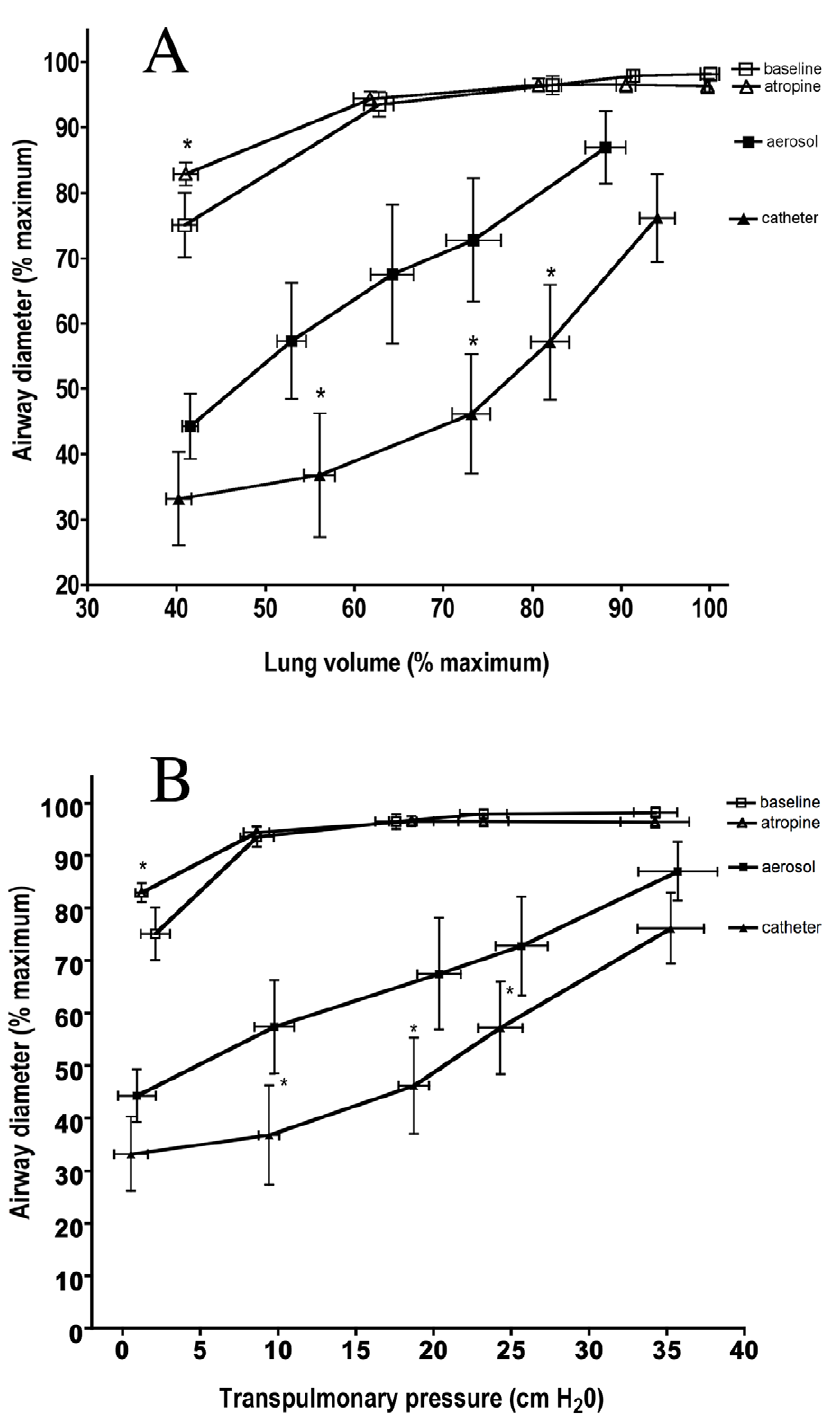
Figure 1. A: The mean ( 6 SEM) airway diameter (as a percentage of the maximum airway diameter) vs. the mean ( 6 SEM) lung volume (as a percentage of the maximum lung volume) at each airway pressure (0, 12, 25, 32, and 45 cm H 2 O) under the four conditions: baseline (before aerosol, open squares), atropine (before catheter, open triangles), aerosol histamine challenge (black squares), and individual airway catheter challenge (black triangles). B: The mean ( 6 SEM) airway diameter (as a percentage of the maximum airway diameter) vs. the mean airway pressure under the same four conditions. There were significant differences in airway diameter and lung volume between the aerosol and catheter challenges. At every airway pressure above 0 cm H 2 O the airways were larger after aerosol challenge than after the local challenge (see text). Also, the aerosol challenge caused a greater stiffening of the lung. (*) At every airway pressure above 0 cm H 2 O, the lung volumes were larger after the catheter challenge than after the aerosol challenge (see text for p-values).